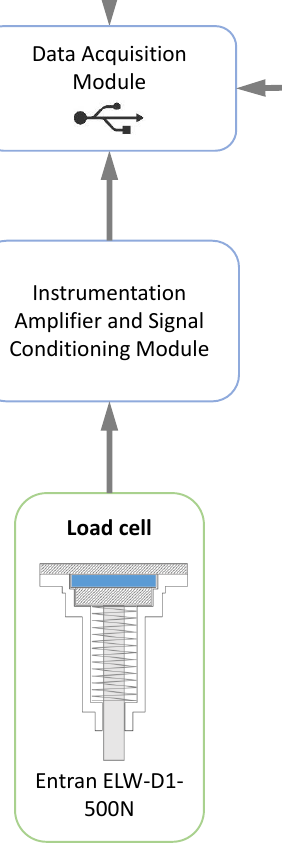
Figure 5. Diagram of the main components of the cutting